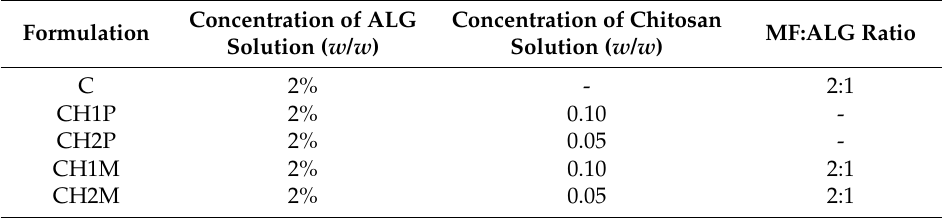
Table 6. Composition of chitosan cross-linked ALG